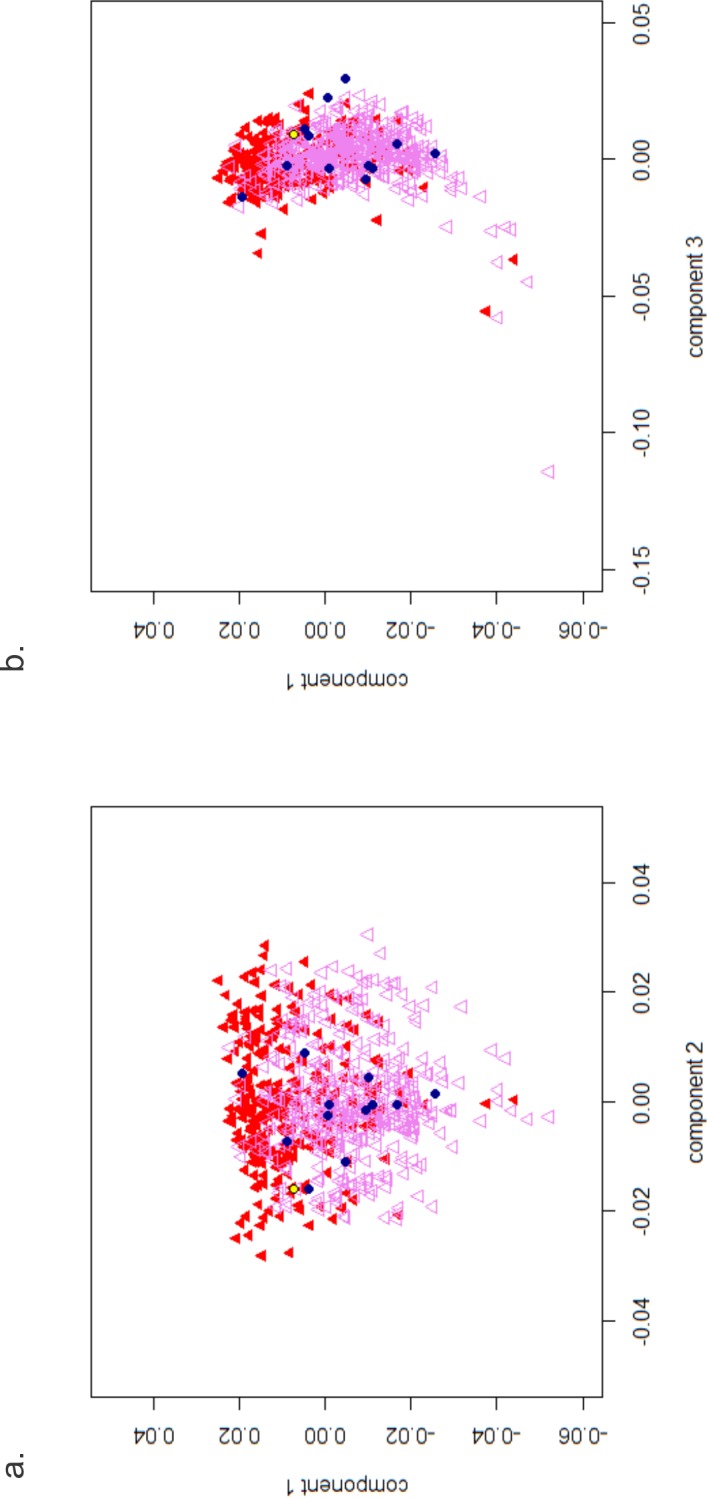
Multidimensional scaling (MDS) plots.Each point represents an individual genome. Red triangles are individuals from the Kuopio region of Finland while violet triangles are individuals from Helsinki. Each blue circle represents a proband from each of the 13 CDGP families. The yellow circle is the proband from Family 1. Panel A shows the relationship between principal components (PCs) 1 and 2, which explain most of the genetic variation. Panel B shows PC1 versus PC3, which appear to mimic a geographical northeast to southwest axis.